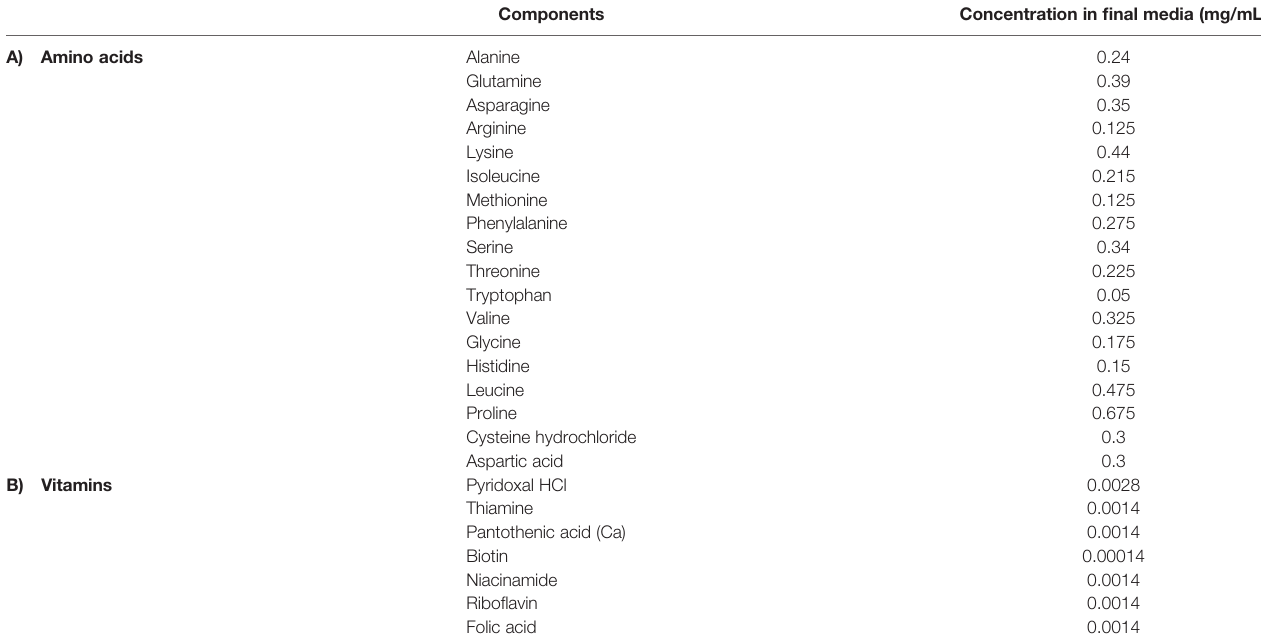
TABLE 1 | Components for the